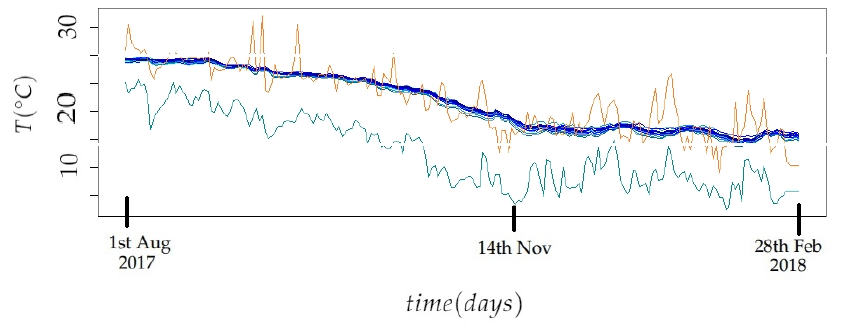
Figure 8. Trajectories of daily-mean temperature over time (days) in the period from August 1st 2017 to February 28th 2018. The green and brown trajectories correspond to the minimum and maximum daily temperature, respectively, in the city of Valencia, Spain. The blue trajectories correspond to temperatures recorded by the 21 sensor nodes inside the church of Saint Thomas and Saint Philip